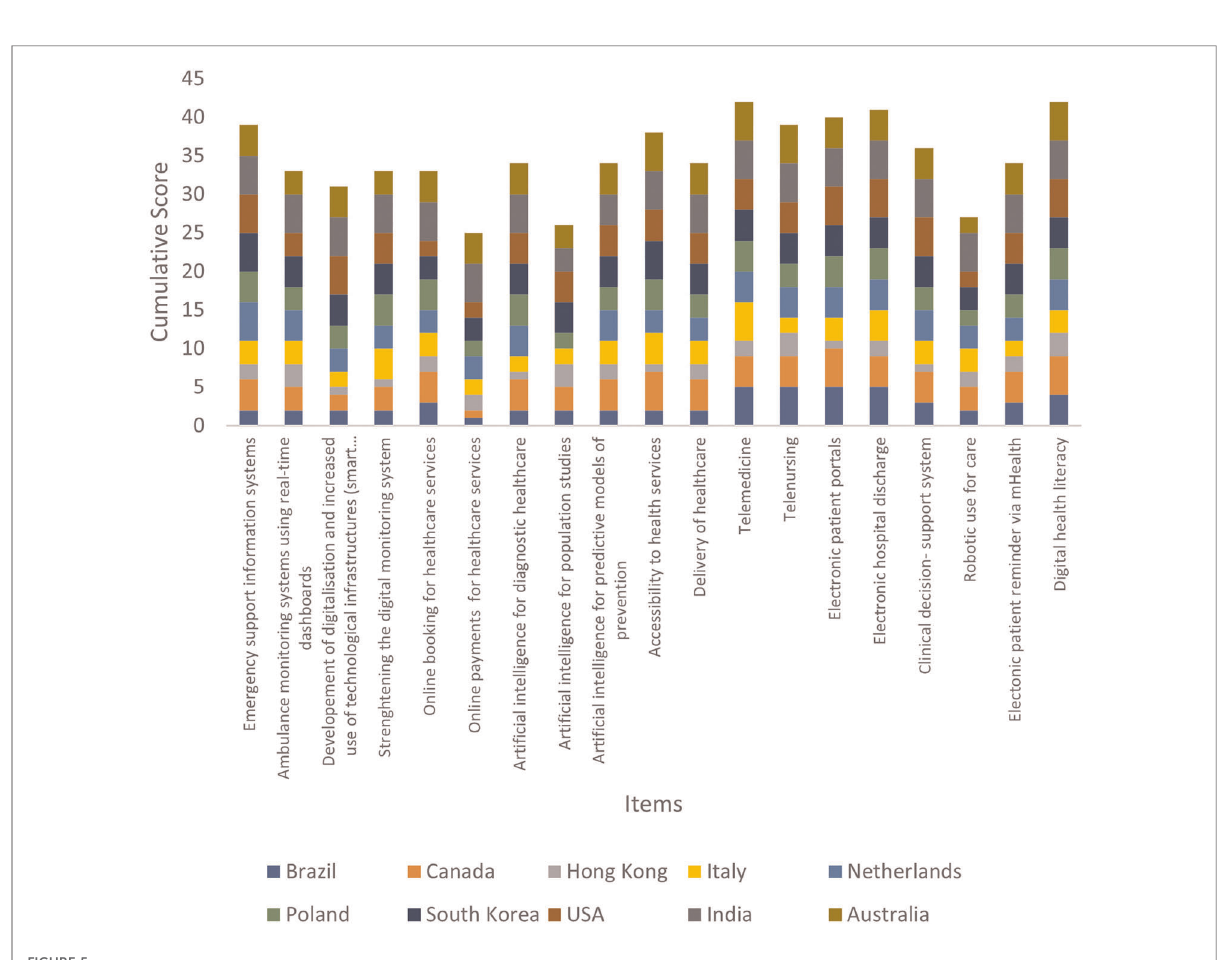
FIGURE 5 Cumulative score per proposed item of Topic